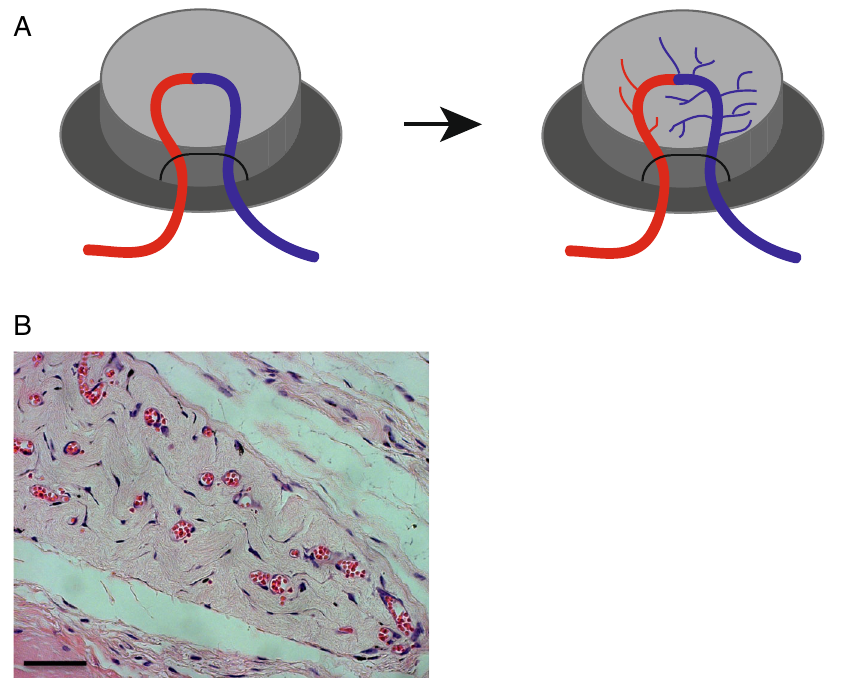
Fig. 1 Approaches to in vivo microvasculature engineering. a Schematic of angiogenic arteriovenous loop. In vivo anastomosis between artery and vein is formed within a protected chamber that is fi ll with extracellular matrix. Angiogenic response is stimulated over time in vivo. b H&E of a section of collagen gel implant containing self-assembled, perfused microvessels after two weeks of subcutaneous implantation within an immunode fi cient mouse. HUVEC and placental perictyes were freely suspended within the gels as decribed in [29] prior to implantations. Scale bar is 50 μ m. Figure reproduced with permission from Oxford University